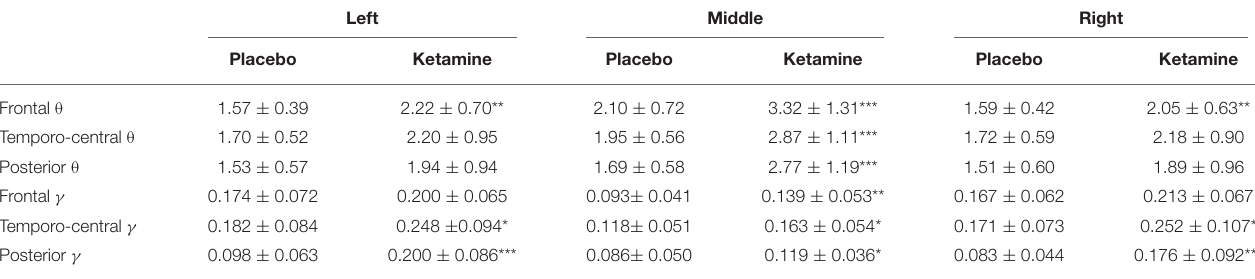
TABLE 1 | Mean power (in µ V ² ) ( ± SD) in the gamma γ (30–40Hz) and theta θ (4–8Hz) frequency range for different regions, laterality and condition (*** p < 0.001, ** p < 0.01, * p < 0.05)]. Left Middle Right Placebo Ketamine Placebo Ketamine Placebo